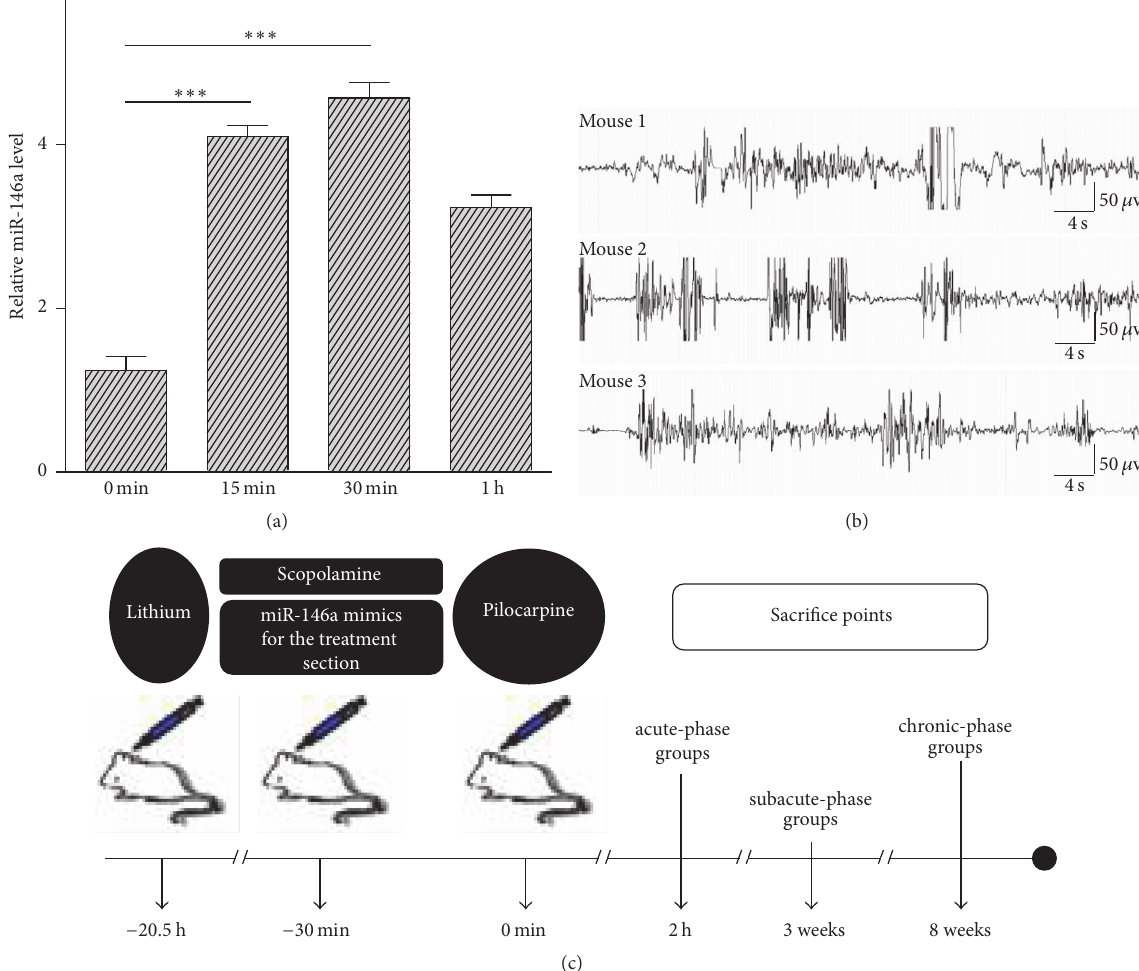
Figure 1: (a) Dynamic changes in relative miR-146a levels in the hippocampus after intranasal delivery of miR-146a mimics. Based on real- time qPCR, the relative miR-146a levels in the hippocampus were gradually upregulated at 15 min and 30 min after intranasal delivery of miR-146a mimics compared with the vehicle control sacrificed at 0 min and then began to decrease at 1h compared with the 3.69-fold peak at 30 min. ∗∗∗ 𝑝 < 0.001 . (b) Effectiveness of the lithium-pilocarpine protocol. While seizures began within 1h after the administration of pilocarpine based on the Racine scale, tonic-clonic discharges were synchronously recorded in all three mice examined using the EEG/EMG acquisition system. (c) Graphic procedure of drug delivery and time of sacrifice in the subsequent